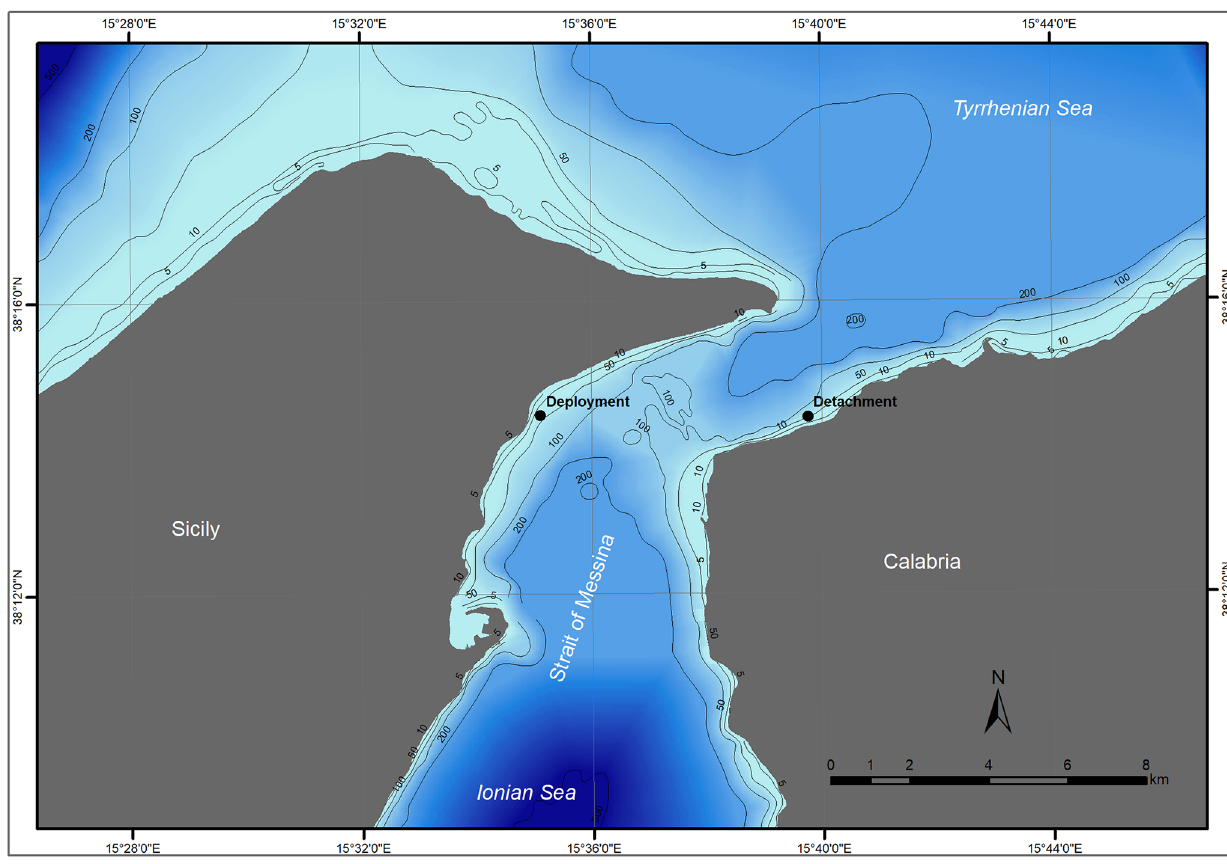
Fig. 1. Study area (Strait of Messina, central Mediterranean), bathymetric information and tag deployment-detachment locations. Image created using ARCGIS v. 10.8.1 while bathymetric data were obtained from digitalised IGM